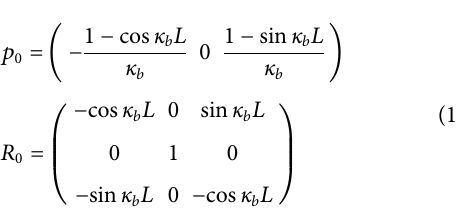
FIGURE 4 | Comparison discretization steps and position deviation for the three different evaluation scenarios for the tube with a pre-curvature of 1/140 mm − 1 .